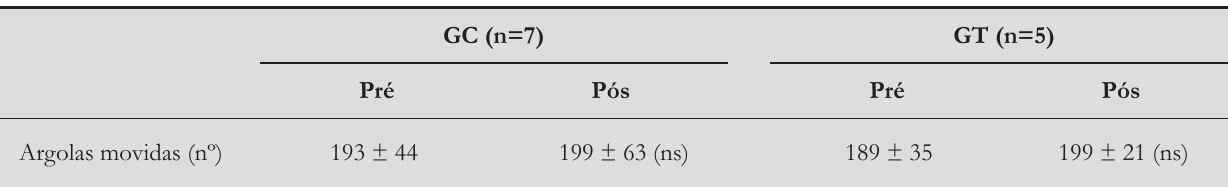
Tabela 3 - Número de argolas movidas no Pegboard and Ring Test (PBRT) nas fases pré e pós-tratamento